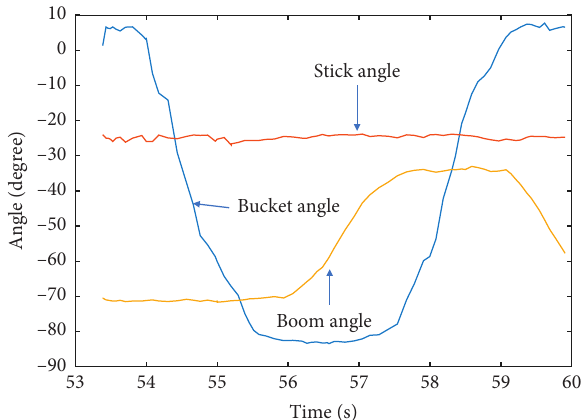
Figure 14: The trajectory of the excavator arm in the joint space in the 4 th period.